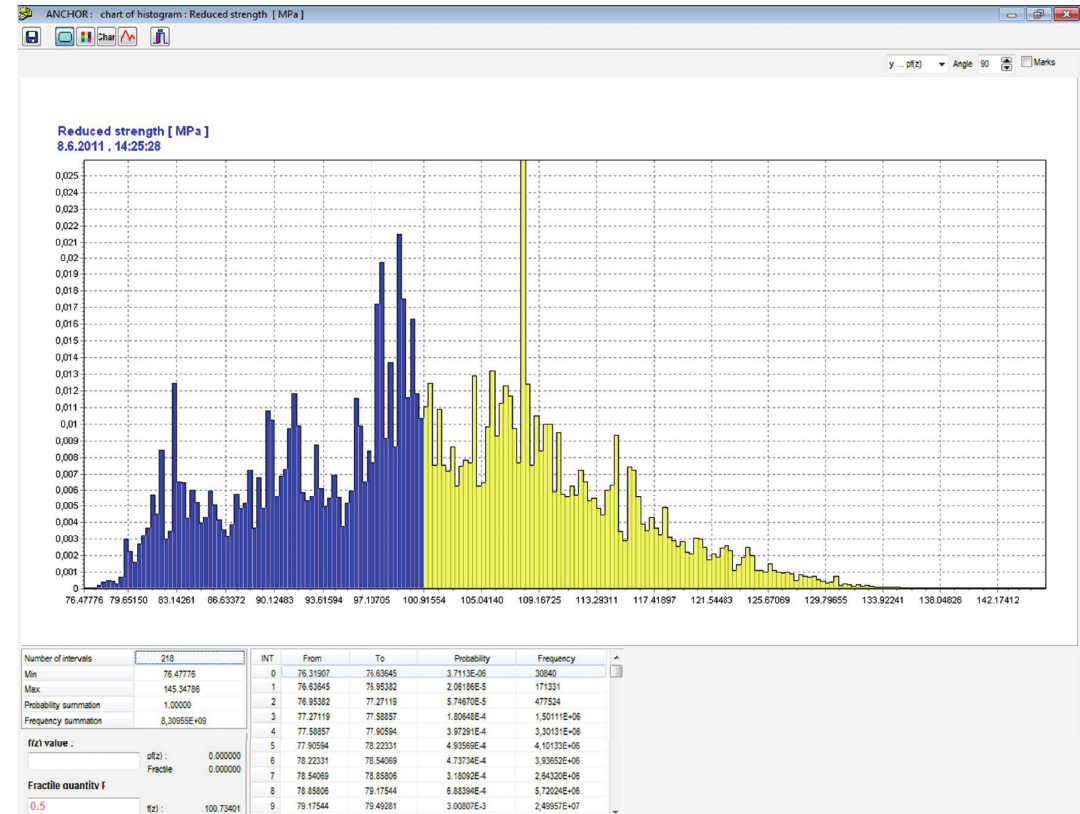
Figure 8: Histogram of the reduced strength of hanging rock 𝜎